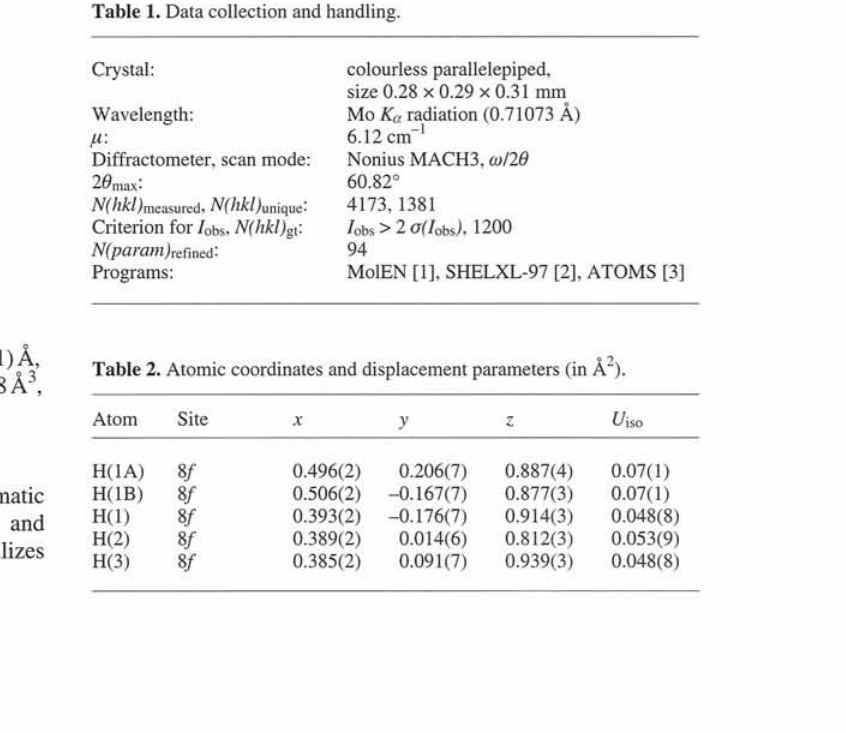
Table 1. Data collection and handling.